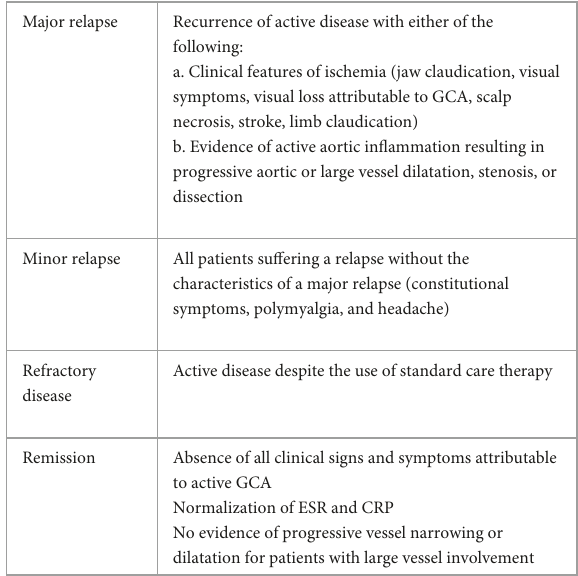
TABLE 7 Definitions of disease activity